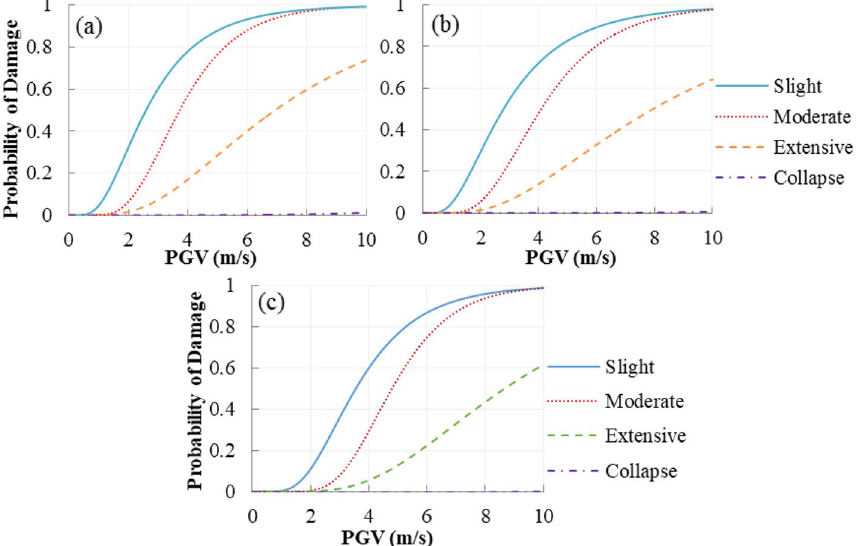
Fig. 13 Fragility curves of bridge pier ( a ) Floating System, ( b ) Rigid System, and ( c )